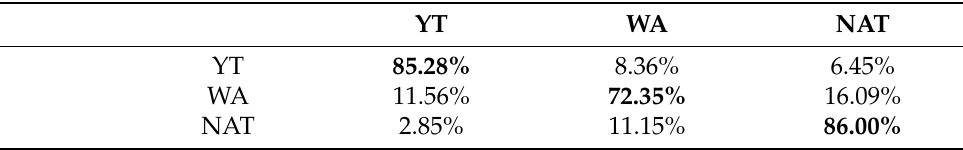
Table 2. Confusion matrix of the baseline single-task model on patches extracted from video frames. YT, WA and NAT represent YouTube, WhatsApp and native video patches